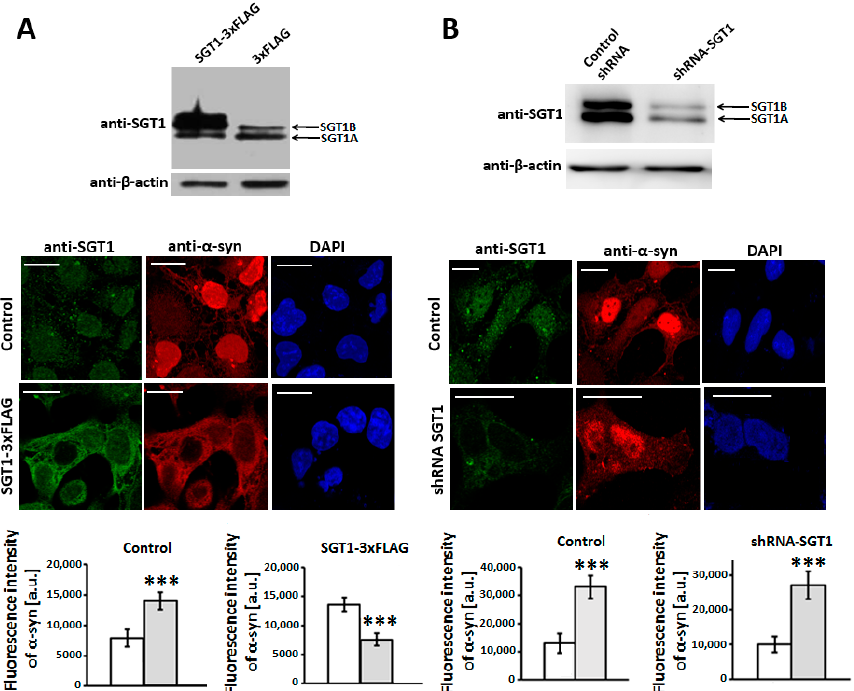
Figure 2. Influence of altered level of SGT1 on α -synuclein subcellular localization in HEK293 cells. ( A , B , upper panels ) Representative Western blots showing the level of SGT1 after overex- pression ( A ) or silencing ( B ) of both isoforms (SGT1A and SGT1B) in total cell lysate. ( A , B , middle panels ) Immunofluorescence staining of cells overexpressing SGT1 (SGT1-3 × FLAG) ( A ) or with di- minished SGT1 level (shRNA-SGT1) ( B ) performed using anti-SGT1 and anti- α -synuclein antibodies. Nuclei, stained with DAPI, are in blue. Scale bar—20 µ m. ( A , B , lower panels ) Statistical analysis of α -synuclein fluorescence staining in cytoplasm (white bar) and nucleus (grey bar) was performed for 20 cells. *** p ≤